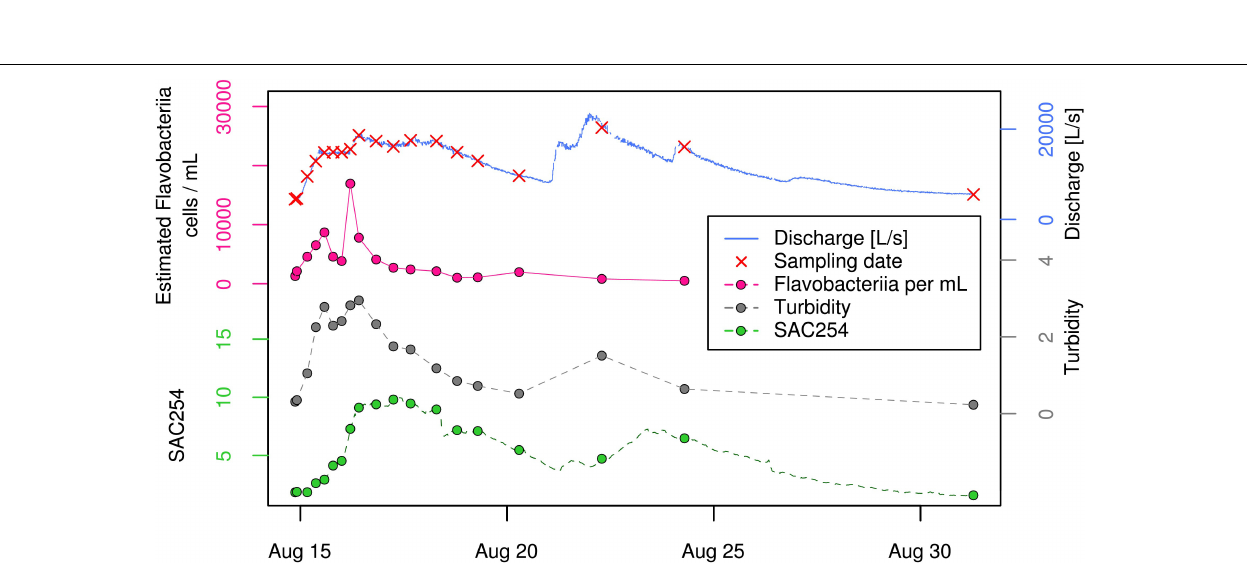
FIGURE 5 | Time-course of “estimated Flavobacteriia concentrations” (pink) along with physical and chemical parameters during the investigated high-discharge event. Spectral Absorption Coefficient at λ = 254 nm (SAC 254 ).